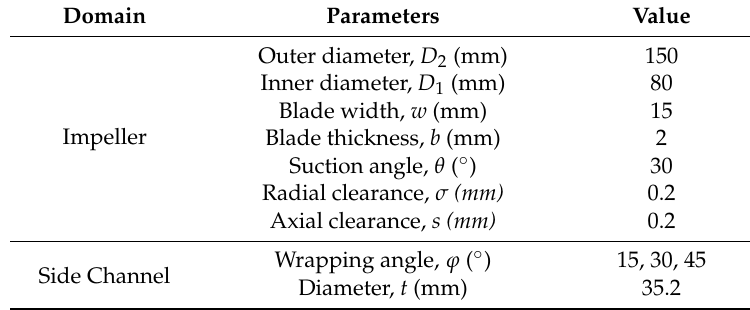
Figure 1. 3D model of a side channel pump. Table 1. Main geometrical